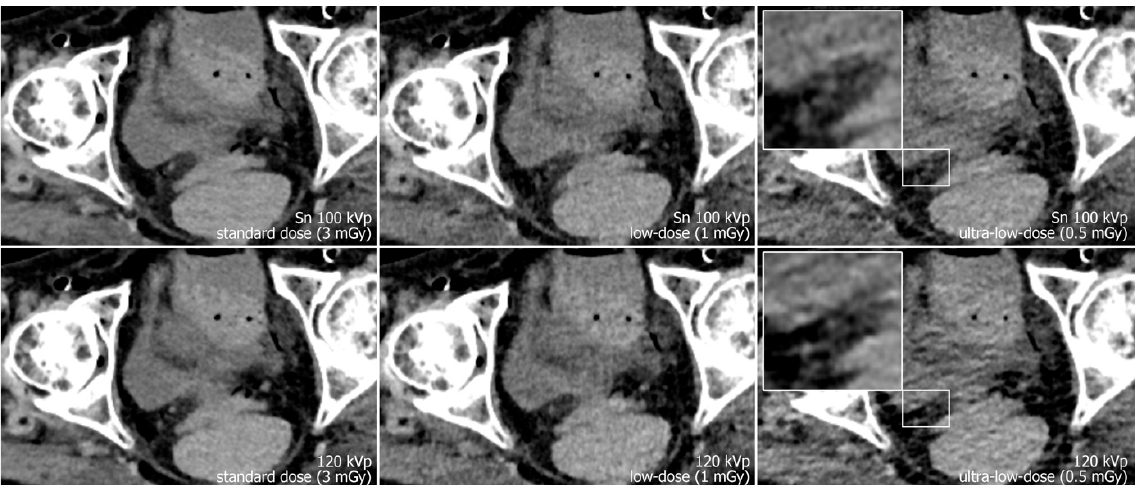
Figure 2. Axial view of the right distal ureter (magnification) in a different specimen. Again, the image quality is reduced and demarcability of the ureter is impaired, especially in ultra-low-dose polychromatic imaging compared to the dose-matched protocol with tin